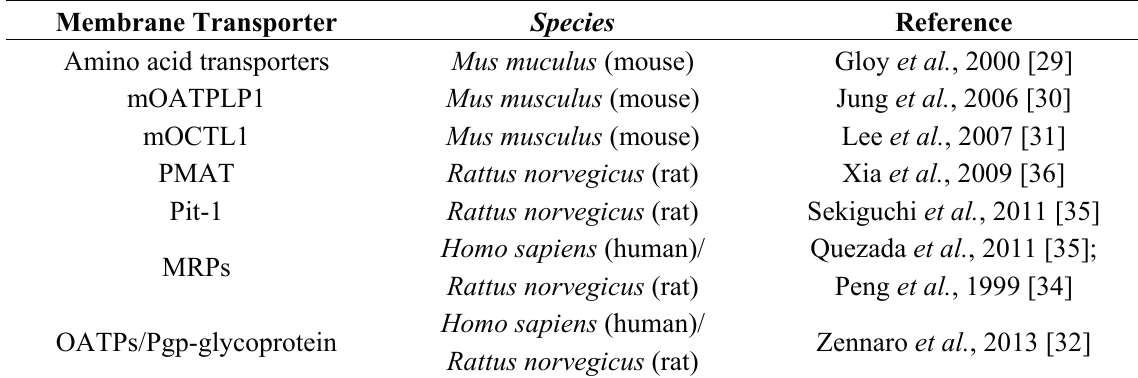
Table 1. Membrane transporters described in the